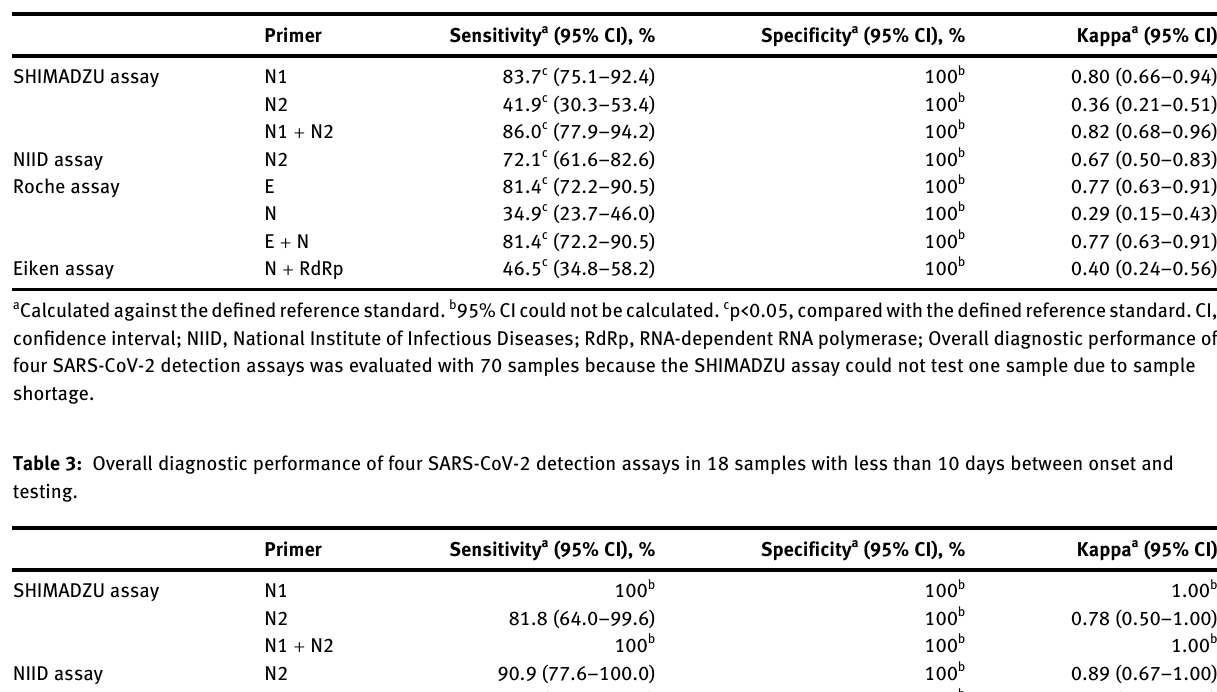
Table  : Overall diagnostic performance of four SARS-CoV-  detection assays in  samples.